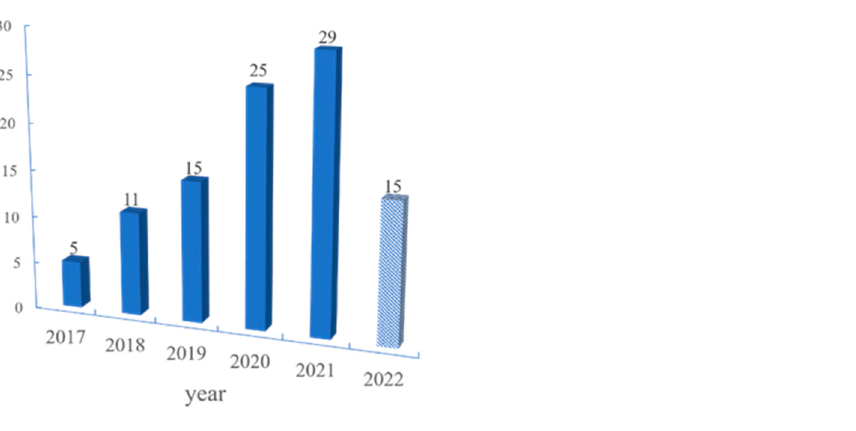
Figure 2. Number of publications vs. year for metal organic frameworks and their derivatives as flame retardants (until June. 2022).